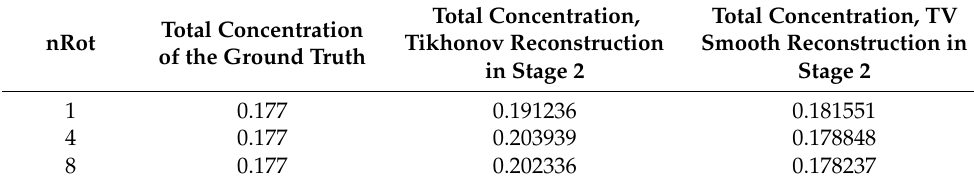
Figure 4. Reconstruction of different concentration levels using model-based two-stage reconstruction for combining rotated scan trajectories. The ground truth consists of four circular regions with decreasing (relative) concentrations levels: 1, 0.75, 0.5, and 0.25. First row. Trace fields u = trace A [ ρ ] (output of Stage 1) obtained with increasing number of rotations 0,4, 8. Second row. Reconstruction results ρ Tik using Tikhonov regularized deconvolution in Stage 2 with increasing number of rotations. Third row. Reconstruction results ρ TV using TV smooth regularized deconvolution in Stage 2 with increasing number of rotations. We observe qualitatively and quantitatively increasing reconstruction quality with increasing number of merged rotated scans for both Tikhonov and TV type regularization. Further, the TV smooth regularized deconvolution in Stage 2 is capable of reconstructing the edges while the Tikhonov regularized deconvolution in Stage 2 smoothes the edges. Table 1. Preservation of the concentration in Experiment